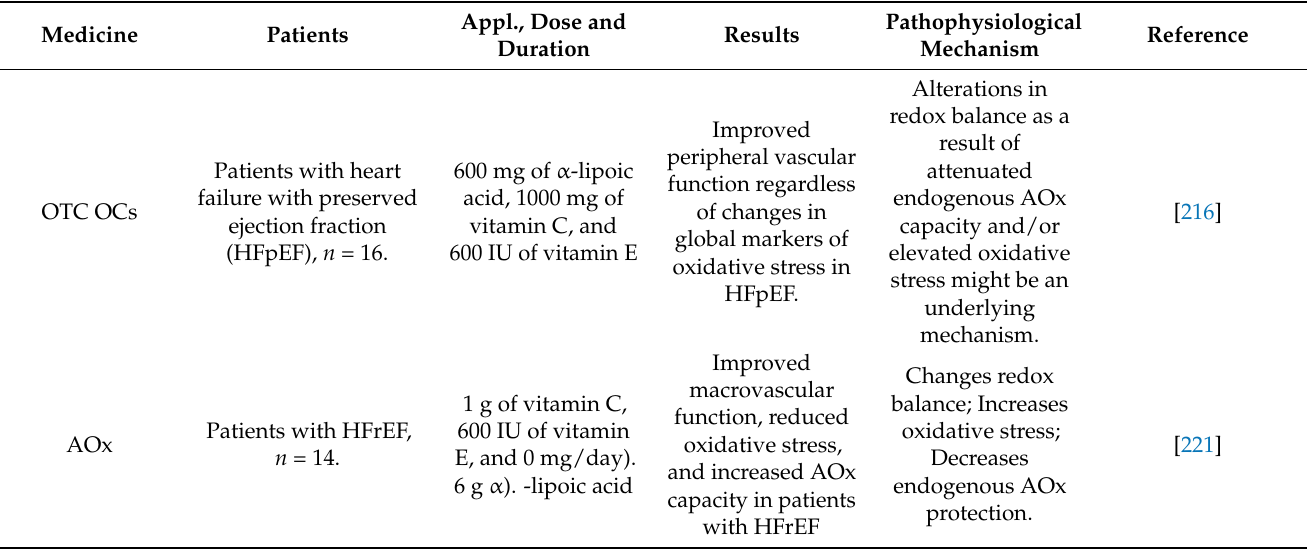
Table 2. Antioxidants affecting human cardiomyocytes in chronic HF